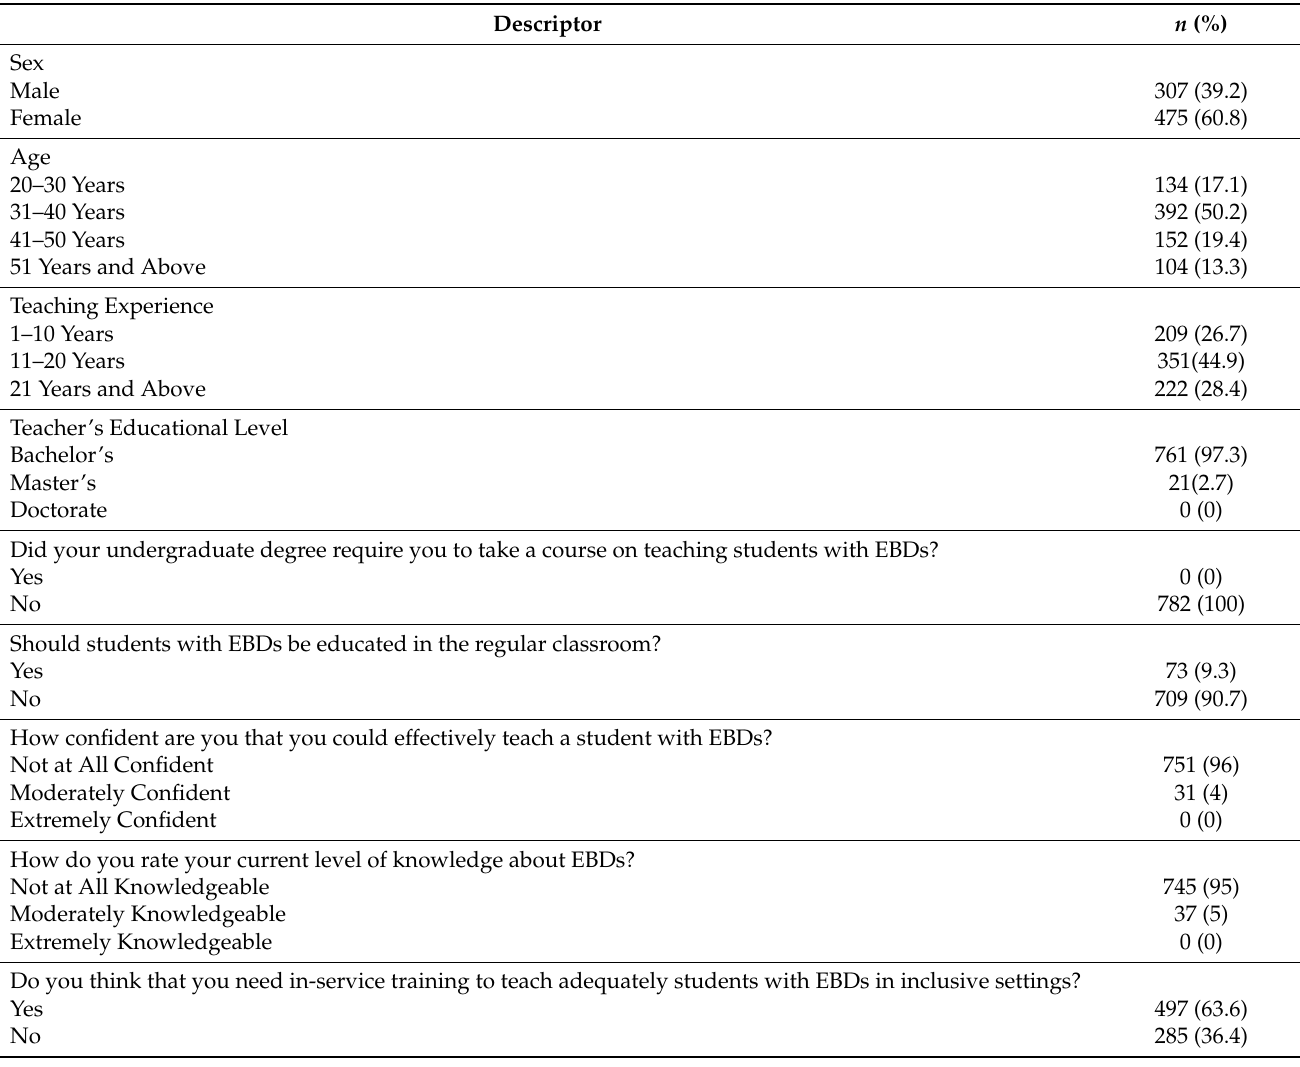
Table 1. Demographic information of the of the Participants ( n =